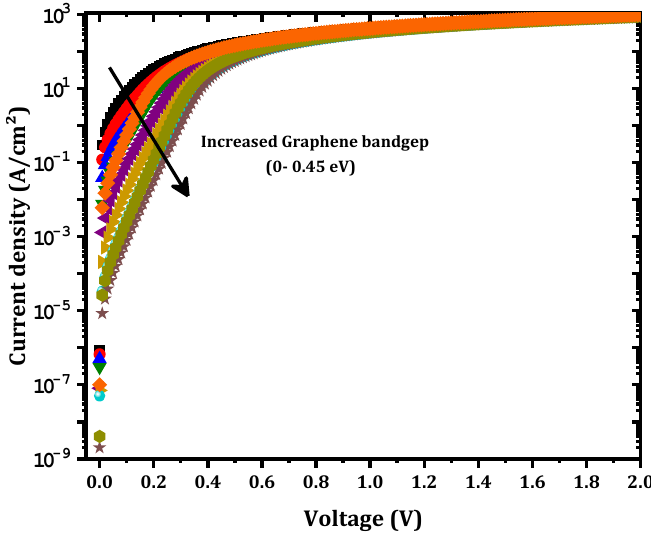
Figure 5. Output J-V variations with the graphene Figure 5. Output J—V variations with the graphene bandgap.